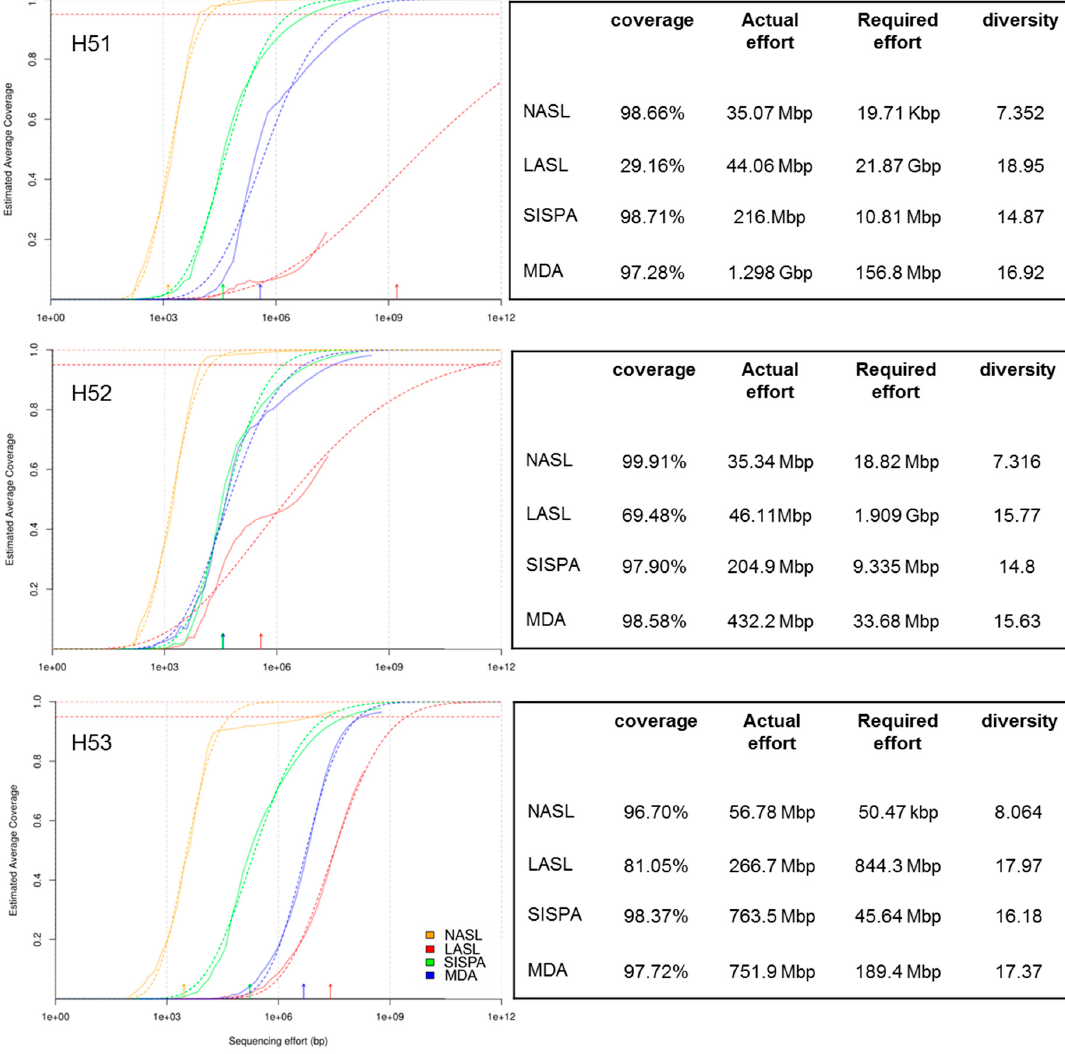
Figure 1. Comparison of Hainich groundwater viromes diversity and coverage as function of sequencing effort using Nonpareil curves [53–55]. Estimated coverage is shown as dotted lines, true coverage as solid lines. Estimated diversity is shown with arrows on the x -axis. Horizontal dotted line shows 95% coverage. Viral metagenome coverage, actual sequencing effort, required sequencing effort and kmer-based diversity for each library are shown in the right panel.